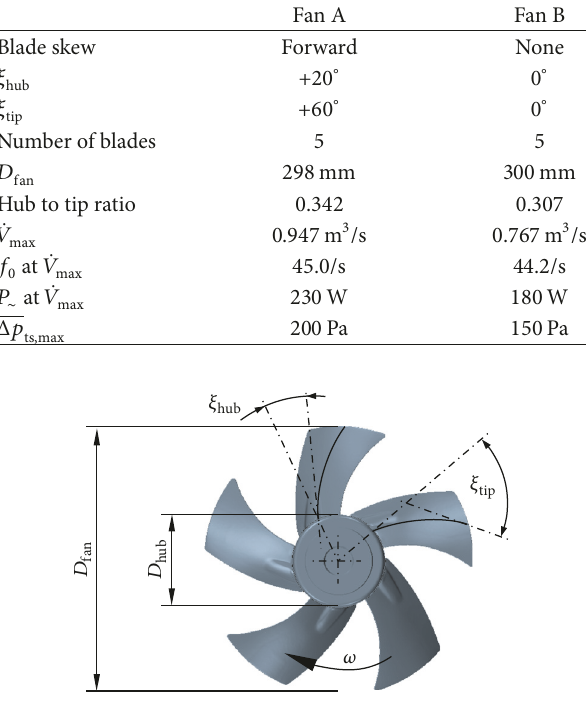
Figure 2: Test fan geometry (Fan